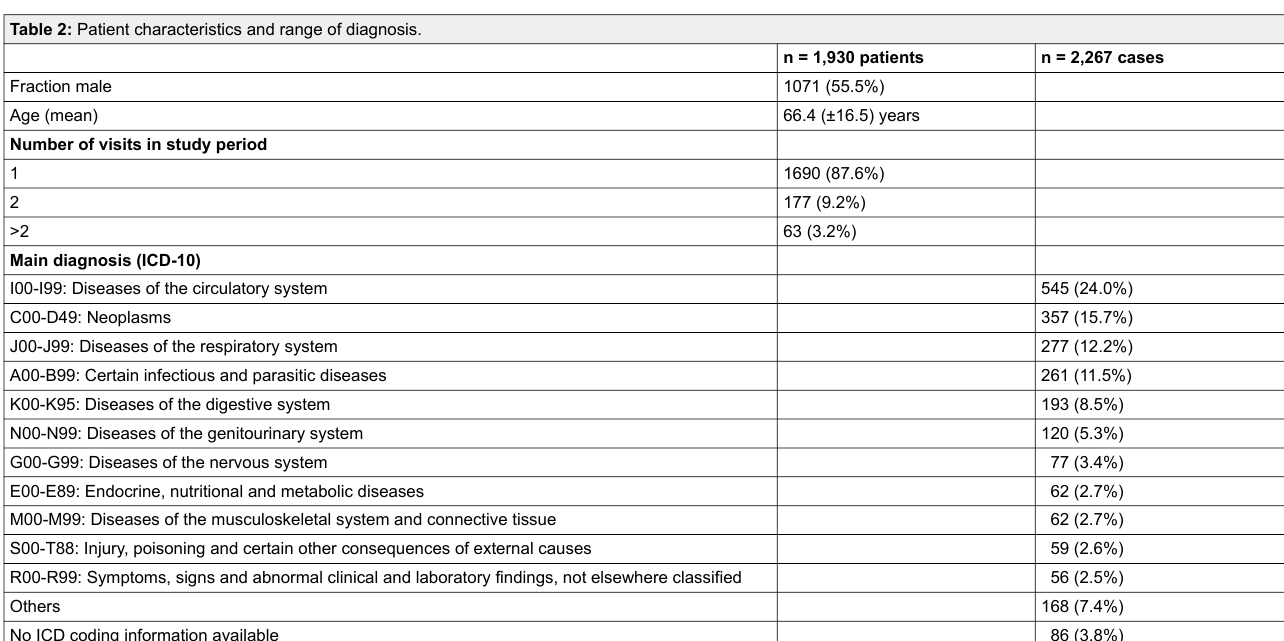
Table 2: Patient characteristics and range of